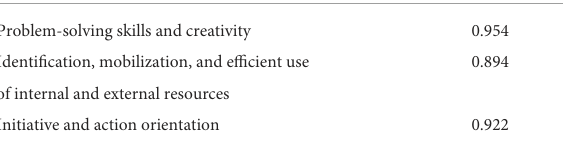
TABLE 2 Cronbach’s alpha values for each entrepreneurship